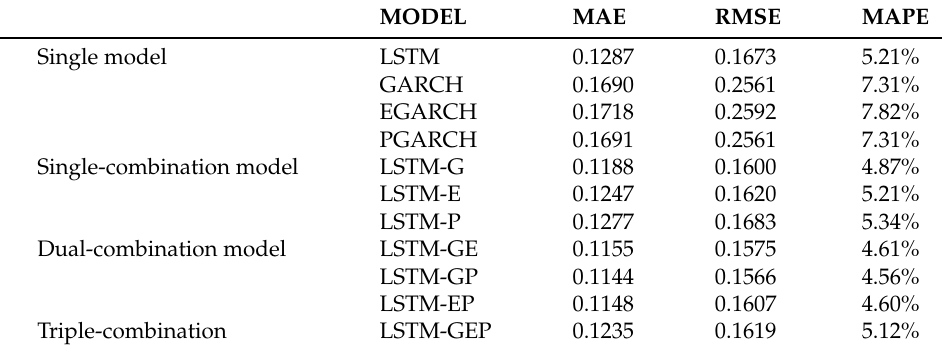
Table 6. Performance comparison among different